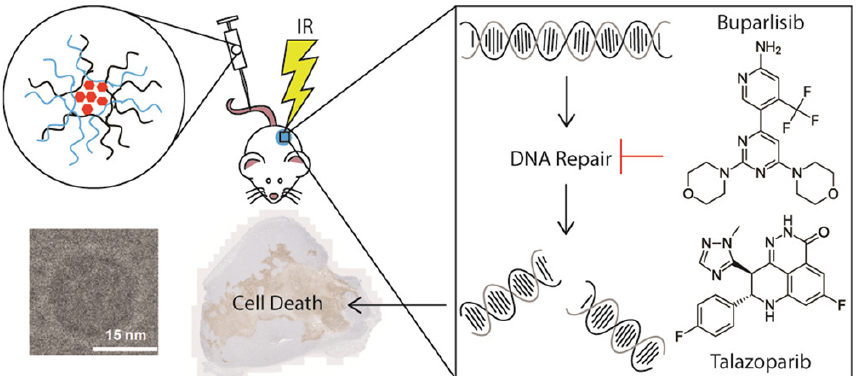
Figure 5. Schematic illustration of the design of MPM with loaded talazoparib and buparlisib, and the combined administration with radiation for enhanced DNA damage. (MPM: mixed poloxamer micelle; IR: irradiation). Reprinted with permission from Ref. [92]. Copyright 2019 American Chemical Society.